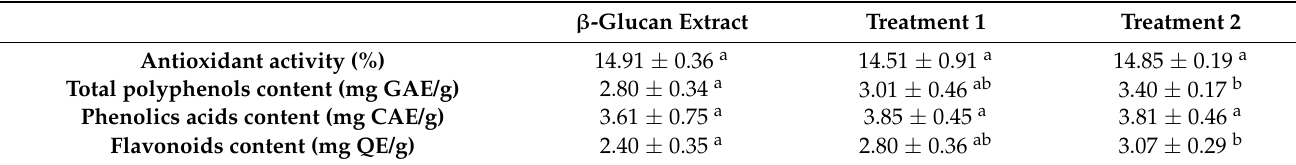
Table 3. Determination of antioxidant activity and biological active compounds. β -Glucan